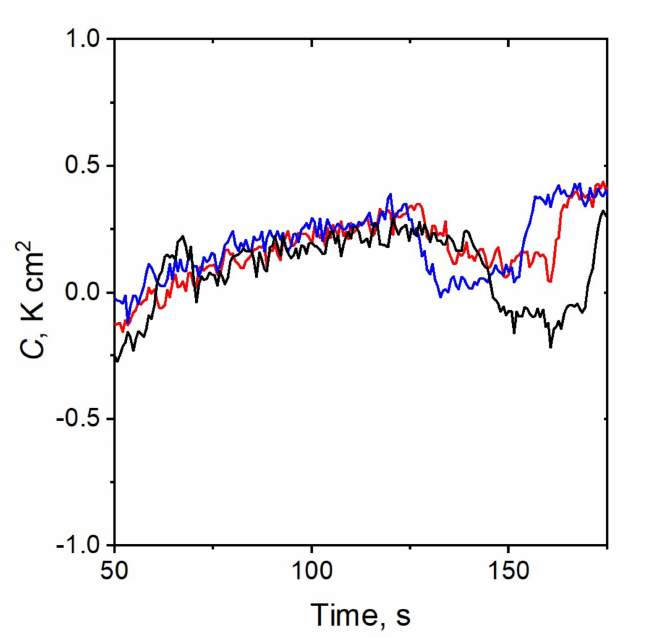
Figure 8. Trace of coefficient C for flames at φ = 0.7 and V g = 17.0 cm/s, with pulse duration of 10 µ s and a frequency of 5 kHz at electric fields of 350 kV/m (red), 370 kV/m (blue) and 380 kV/m